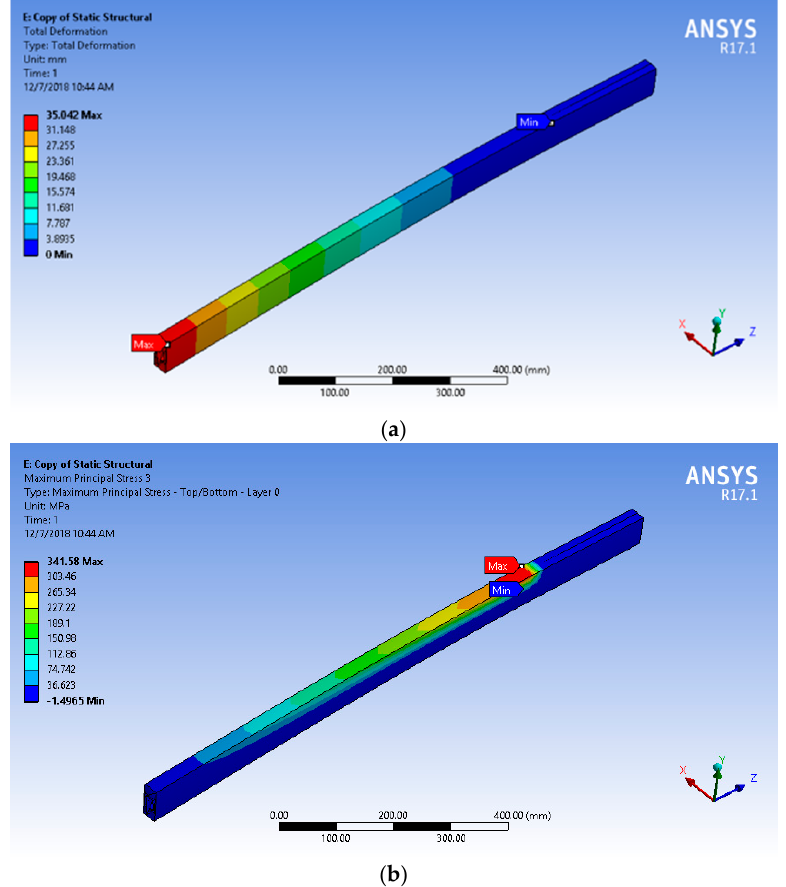
Figure 12. Finite Element Method (FEM) simulation results of the aileron beam in cantilever: ( a ) Total deformation; ( b ) Maximum principal stresses σ 1 .